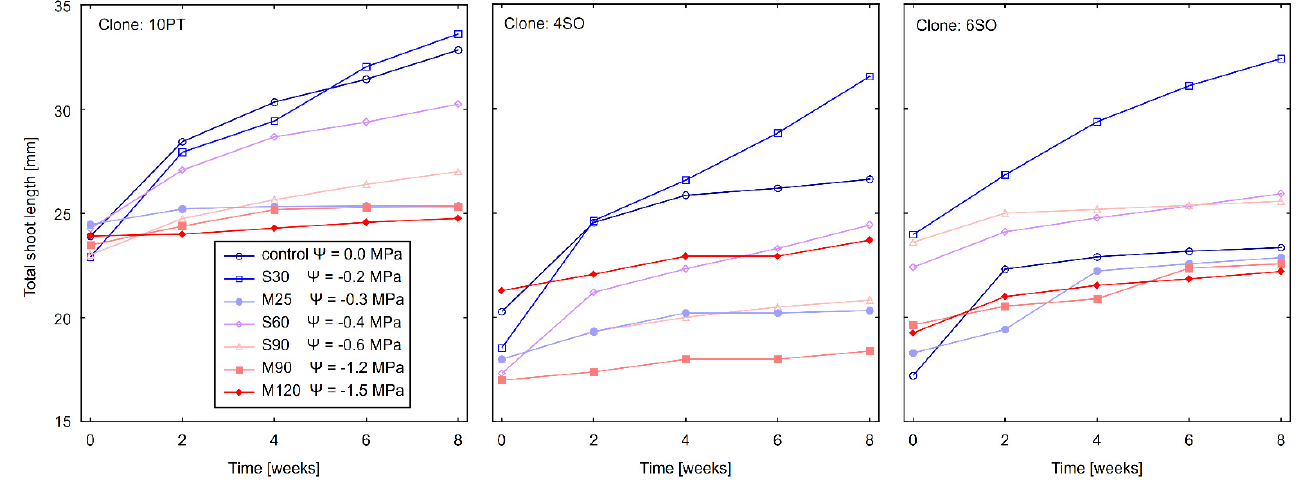
Figure 2. Effect of different osmoticum treatments on total shoot length TSL of Robinia pseudoacacia clones (10PT, 4SO, 6SO) during 8 weeks of treatment. Different treatments are denoted by the wa-